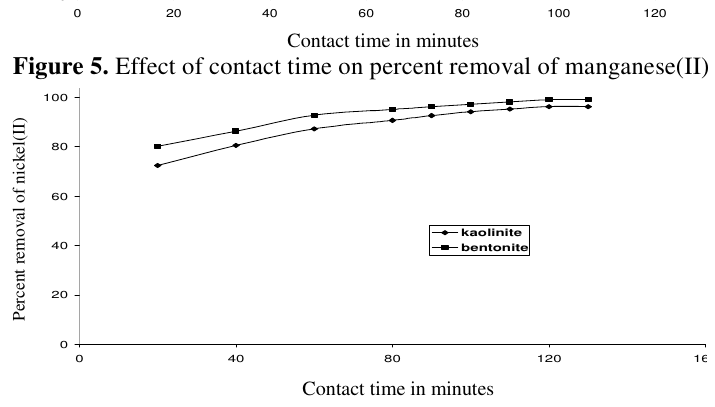
Figure 6. Effect of contact time on percent removal of nickel(II) Table 6. Effect of contact time on percent removal of manganese(II) Adsorbents * Contact time, minutes Kaolinite Bentonite